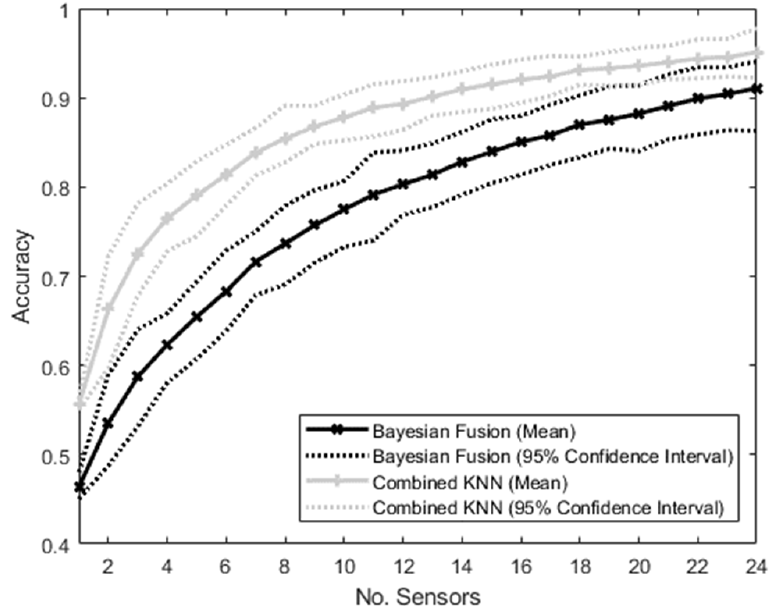
Figure 6. Graph showing the accuracy of the intent-classification system using the Bayesian Fusion method (treating each sensor separately and then combining them) and the combined method (putting all sensor information into a single KNN classifier) as the number of sensors increases. No sensors dropped out—instead, the number of sensors was varied from 1 to 24, and the algorithms were trained on the number of sensors active in each case.